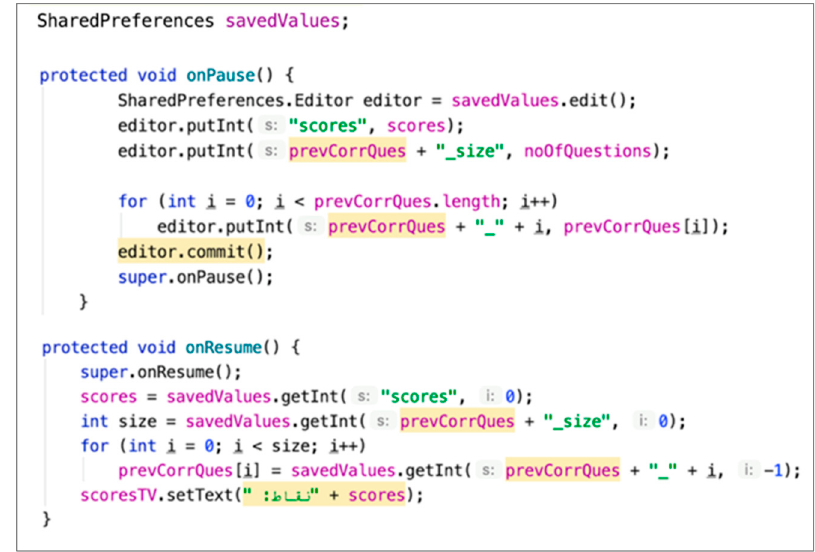
Figure 11. The onPause and onResume methods of the App.